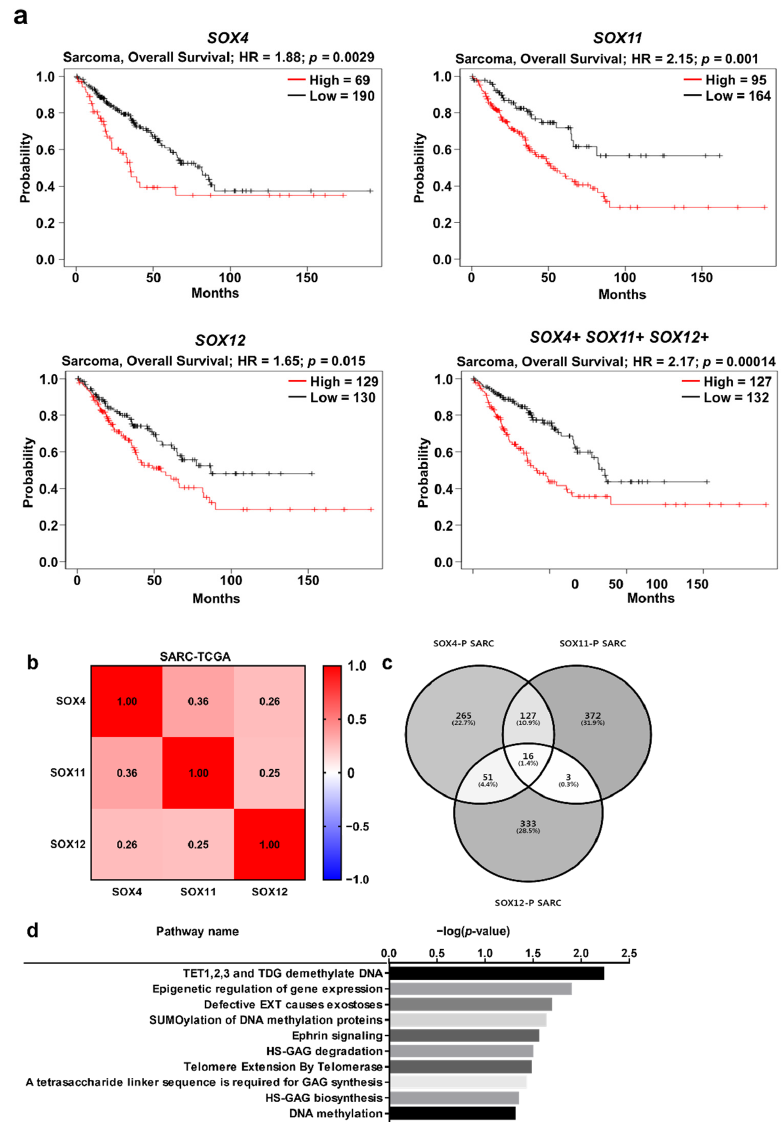
Figure 6. Correlation of SOX4 , SOX11 , and SOX12 expression with the prognosis of sarcoma, and analysis of positively correlated genes with the three SOX genes. ( a ) Survival curve comparing patients with high (red) and low (black) expression of each SOX gene from the Kaplan–Meier plotter. The plotters were analyzed for sarcoma. ( b ) Correlation heat map of SOX4, SOX11 , and SOX12 expression data, generated using TCGA-SARC RNA sequencing data from cBioPortal database. Pearson’s correlation was calculated among the three SOX genes to determine the co-expression pattern of genes in the heat map. ( c ) Venn diagram of the genes positively correlated with the three SOX genes, generated using the -TCGA-SARC dataset from the R2 database. ( d ) Reactome pathway analysis of the genes positively correlated with the three SOX genes, using TCGA-SARC transcriptome